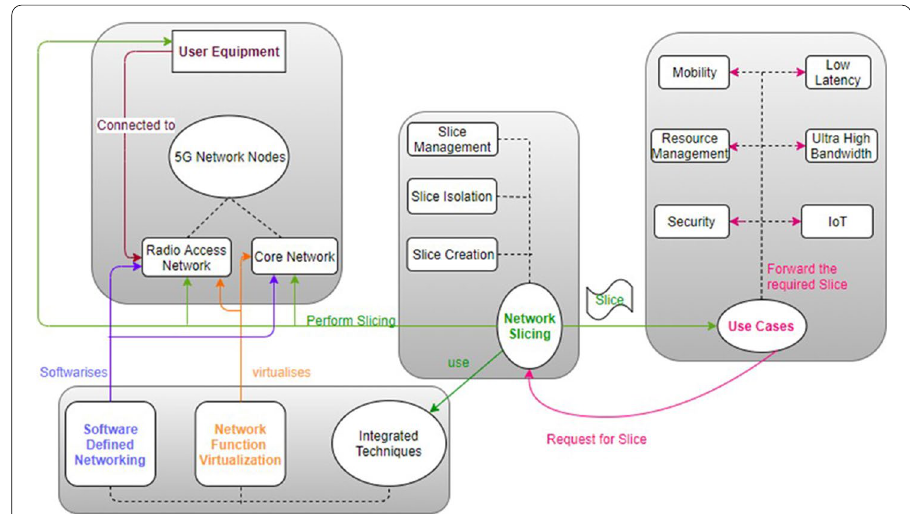
Fig. 3 Proposed network slicing model. Dotted lines show sub-components whereas solid lines depict an action or process coloured solid line are used to show which process is involved with each component/ sub-component. The process belongs to the sub-component from which the solid line starts from. For example, blue solid line belongs to the SDN sub-component as the blue solid line starts from SDN sub-component and ends at RAN sub-component. Blocks are used to group each component and its sub-component to a single